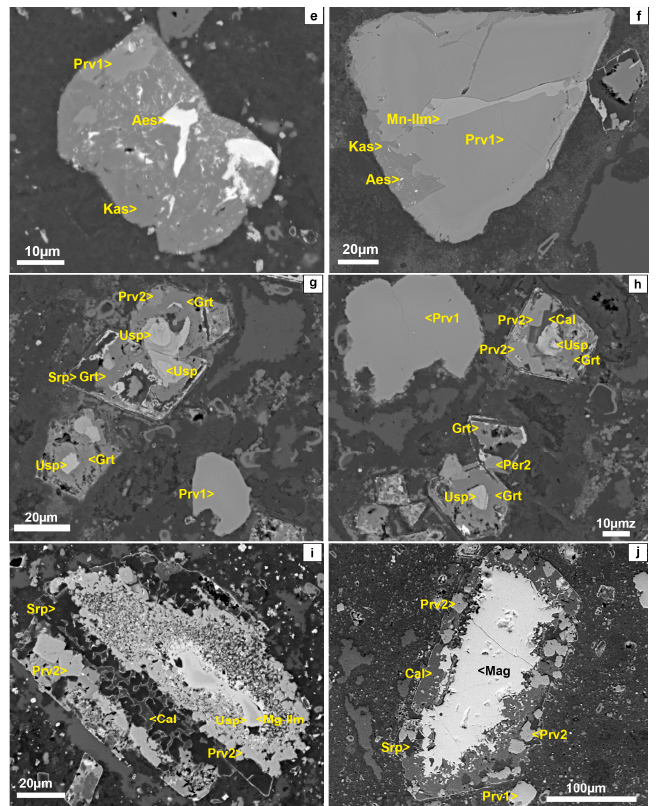
Figure 2. Representative SEM (BSE) images of the groundmass from SK-1 and SK-2 kimberlites. ( a ) Type 1 perovskite (Prv1) with an ulvöspinel inclusion (Usp) from SK-1 kimberlites being replaced by anatase (Ant) along borders and fractures; ( b ) Euhedral atoll spinel from SK-1, replaced by serpentine (Srp), calcite (Cal) and cryptocrystalline Ti-rich garnets (Grt), with a relict of ulvöspinel (Usp) in the centre of the crystal; ( c ) Atoll spinel from SK-1, altered to serpentine, calcite, magnetite (Mag) and cryptocrystalline Ti-rich garnets, with a relict of titanomagnetite (Ti-Mag) in the centre; ( d ) Type 1 groundmass perovskite from SK-2 kimberlite, replaced by kassite (Kas) with aeschynite (Aes); ( e ) Type 1 groundmass perovskite from SK-2, replaced by kassite with aeschynite; ( f ) Type 1 perovskite from SK-2, altered to kassite and aeschynite (Kas + Aes) in grain borders; the ensemble is replaced by Mn-rich ilmenite (Mn-ilm) along fractures and grain borders; ( g ) Groundmass atoll spinel from SK-2 altered to type 2 perovskite (Prv2), Ti-rich garnets and serpentine, showing ulvöspinel relicts; ( h ) Atoll groundmass spinel from SK-2 altered to type 2 euhedral perovskite, Ti-rich garnets and calcite, showing relicts of ulvöspinel and type 1 perovskite; ( i ) Mg-rich ilmenite (Mg-ilm) from SK-2, replaced by ulvöspinel, which on its turn is replaced by type 2 perovskite, calcite and serpentine; ( j ) Magnetite from SK-2, replaced by type 2 euhedral perovskite, serpentine and calcite.